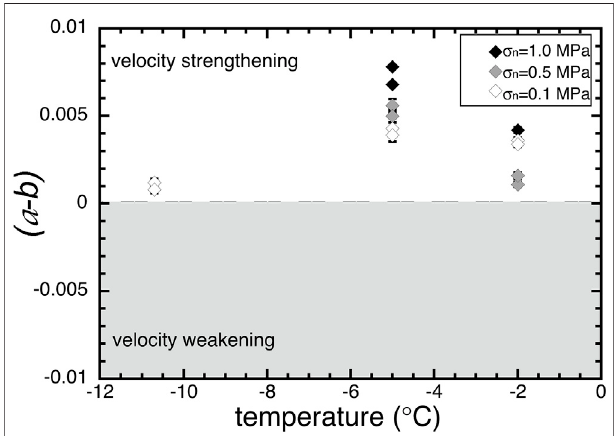
FIGURE 8 | Rate dependence of friction, a-b , vs. temperature, from experiments C34-44 each measured from a velocity step from 1 μ m/s to 10 μ m/s using the GUI described in Skarbek and Savage, 2019. Where error bars cannot be seen, they are smaller than the symbol size. Analysis of velocity steps indicates only velocity strengthening behavior over this temperature/velocity